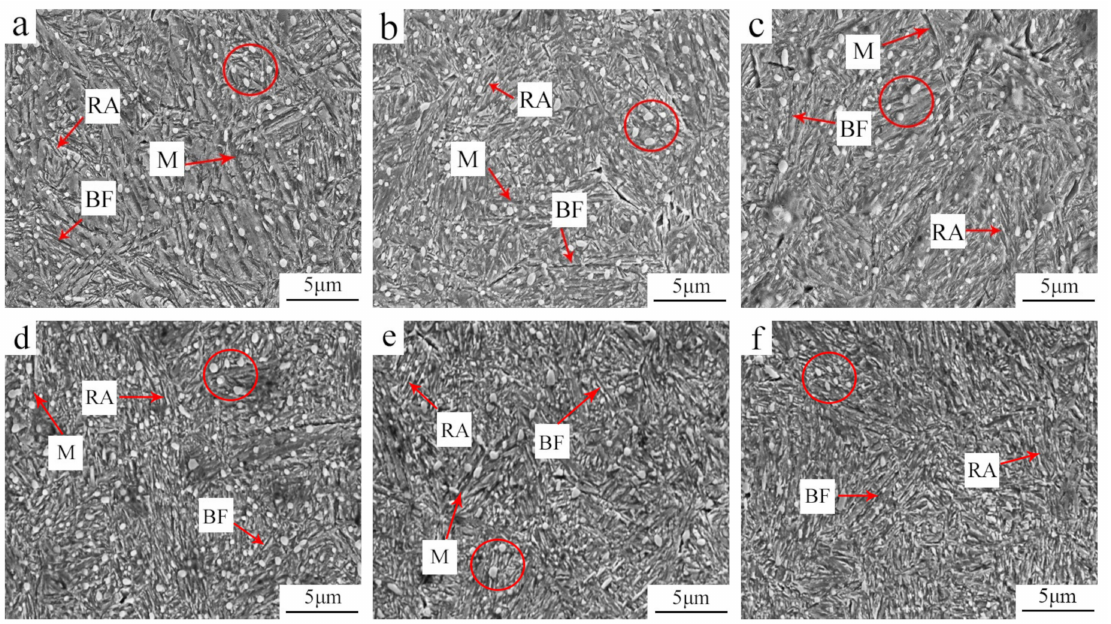
Figure 4. SEM images: ( a – c ) are at 210 ◦ C for 6, 12, and 24 h; ( d – f ) are at 230 ◦ C for 6, 12, and 24 h, respectively. Notes: BF—bainitic ferrite, M—martensite, and RA—retained austenite.